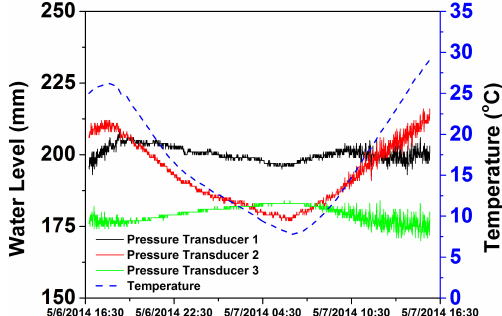
Figure 2. Water levels from three pressure transducers during a 24h period when the cables were exposed to sunlight. Left y axis shows the water level measurement and right y axis shows the water tem- perature inside the bucket.